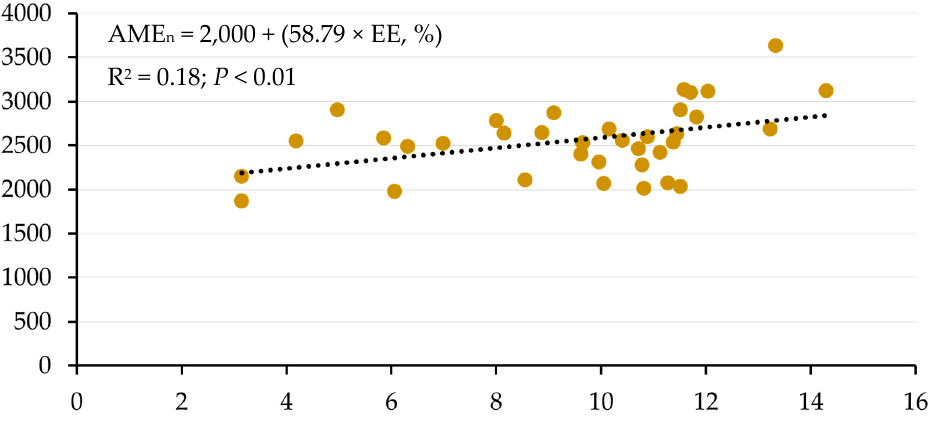
Figure 1. Linear regression of nitrogen-corrected apparent metabolizable energy (AME n , kcal/kg, dry-matter basis) determined in broiler chickens on ether extract (EE) content (%, dry matter basis) of 36 samples of distillers dried grains with solubles. Data from Rochell et al. [13] and Meloche et al. [14,15].